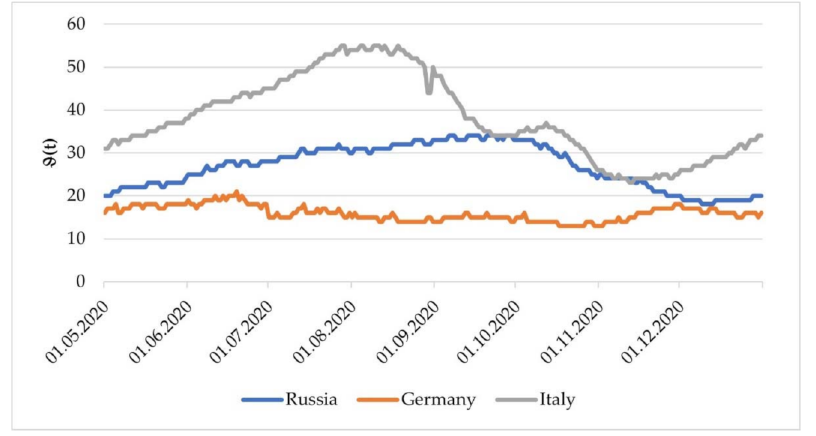
Figure 1. ϑ ( t ) dynamics for Russia, Germany and Italy during the time period of May to Decem- ber